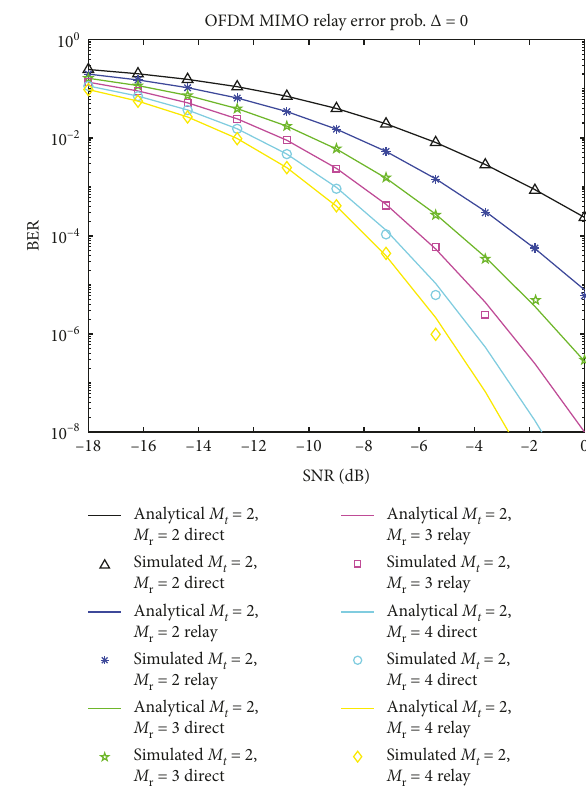
Figure 4: Outage probability with MIMO-OFDM direct and relay ( Δ � 1).